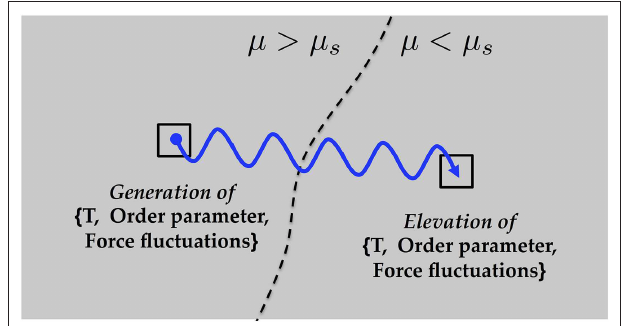
FIGURE 2 | The basic “self-heating” picture common to many recent non-local models [50–53]. Zones whose stress ratio µ are beneath the local friction coefficient µ s can be made to flow in inhomogeneous stress environments by diffusive passage of a state field (e.g., temperature, order-parameter, force-fluctuations) sourced in higher stress media nearby, which spreads over some grain-size dependent correlation length. The influx elevates the value of the state field in the low-stress media, which reduces its flow resistance and allows flow to occur. The newly “heated” material then “heats” neighboring material triggering a cascade that causes all material to v , and the ∇ ×